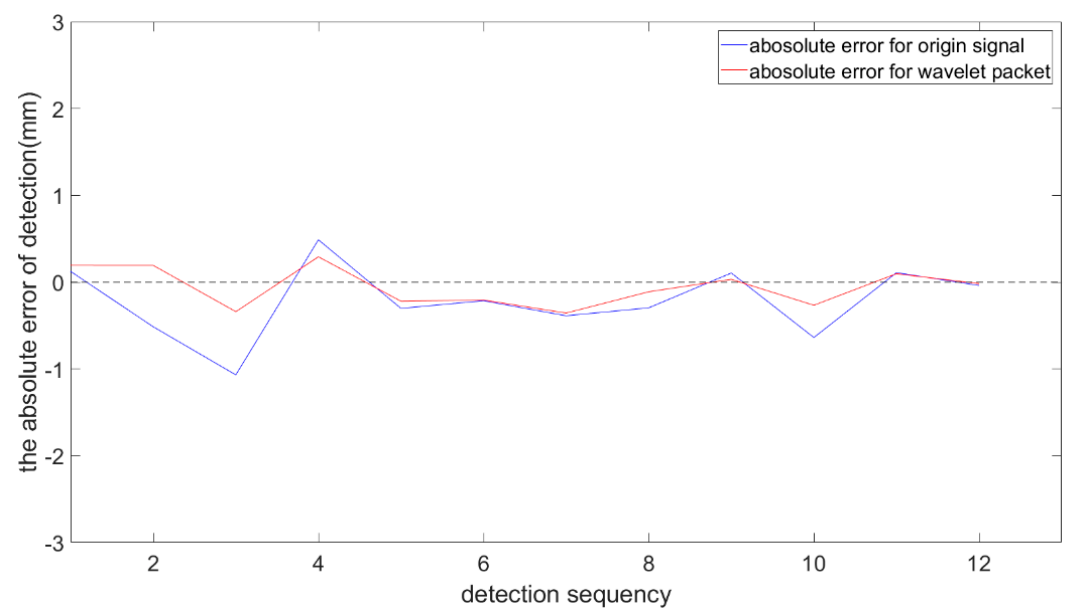
Figure 19. The absolute error of detection in the experiments. Table 6. Comparison of detection errors at 200 Hz sampling frequency.